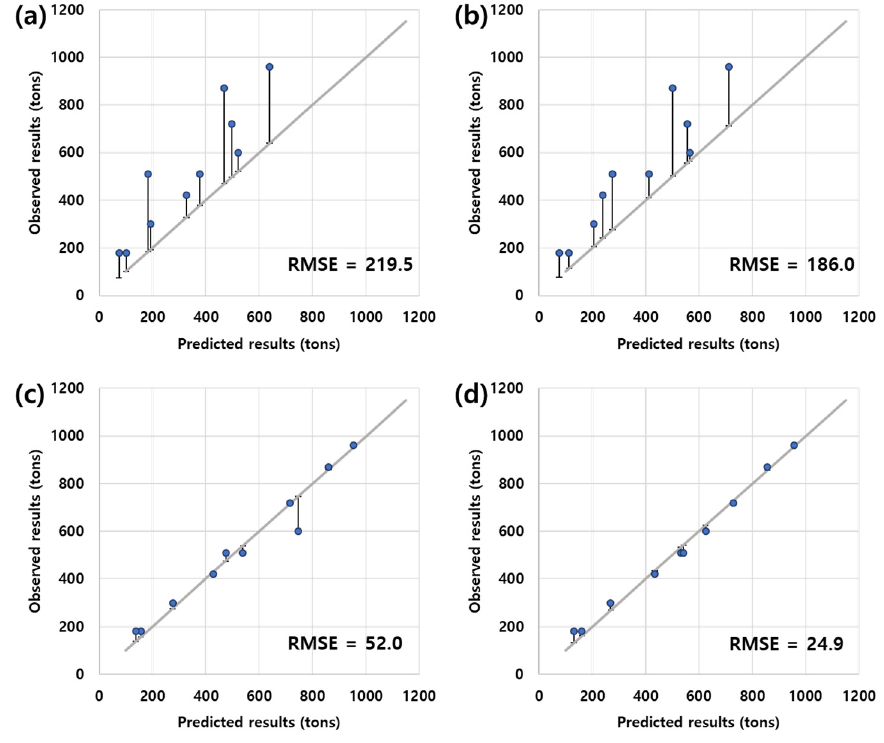
Figure 10. Results of the correlation analysis between the predicted and observed ore productions for ten days in October 2018 for ( a ) uniform distribution, ( b ) triangular distribution, ( c ) normal distribution, and ( d ) observed probability distribution.